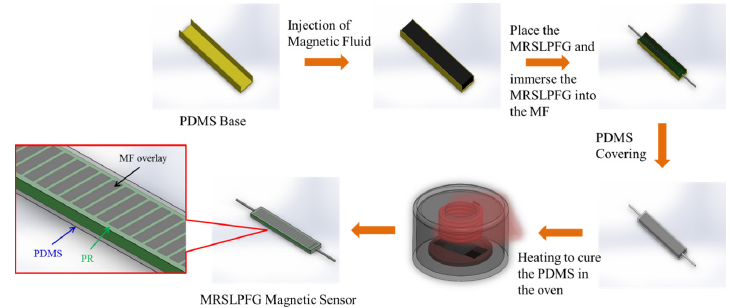
Figure 2. Schematic diagram of the production process of the micro rectangular-shaped long-period fiber grating (MRSLPFG) magnetic sensor.